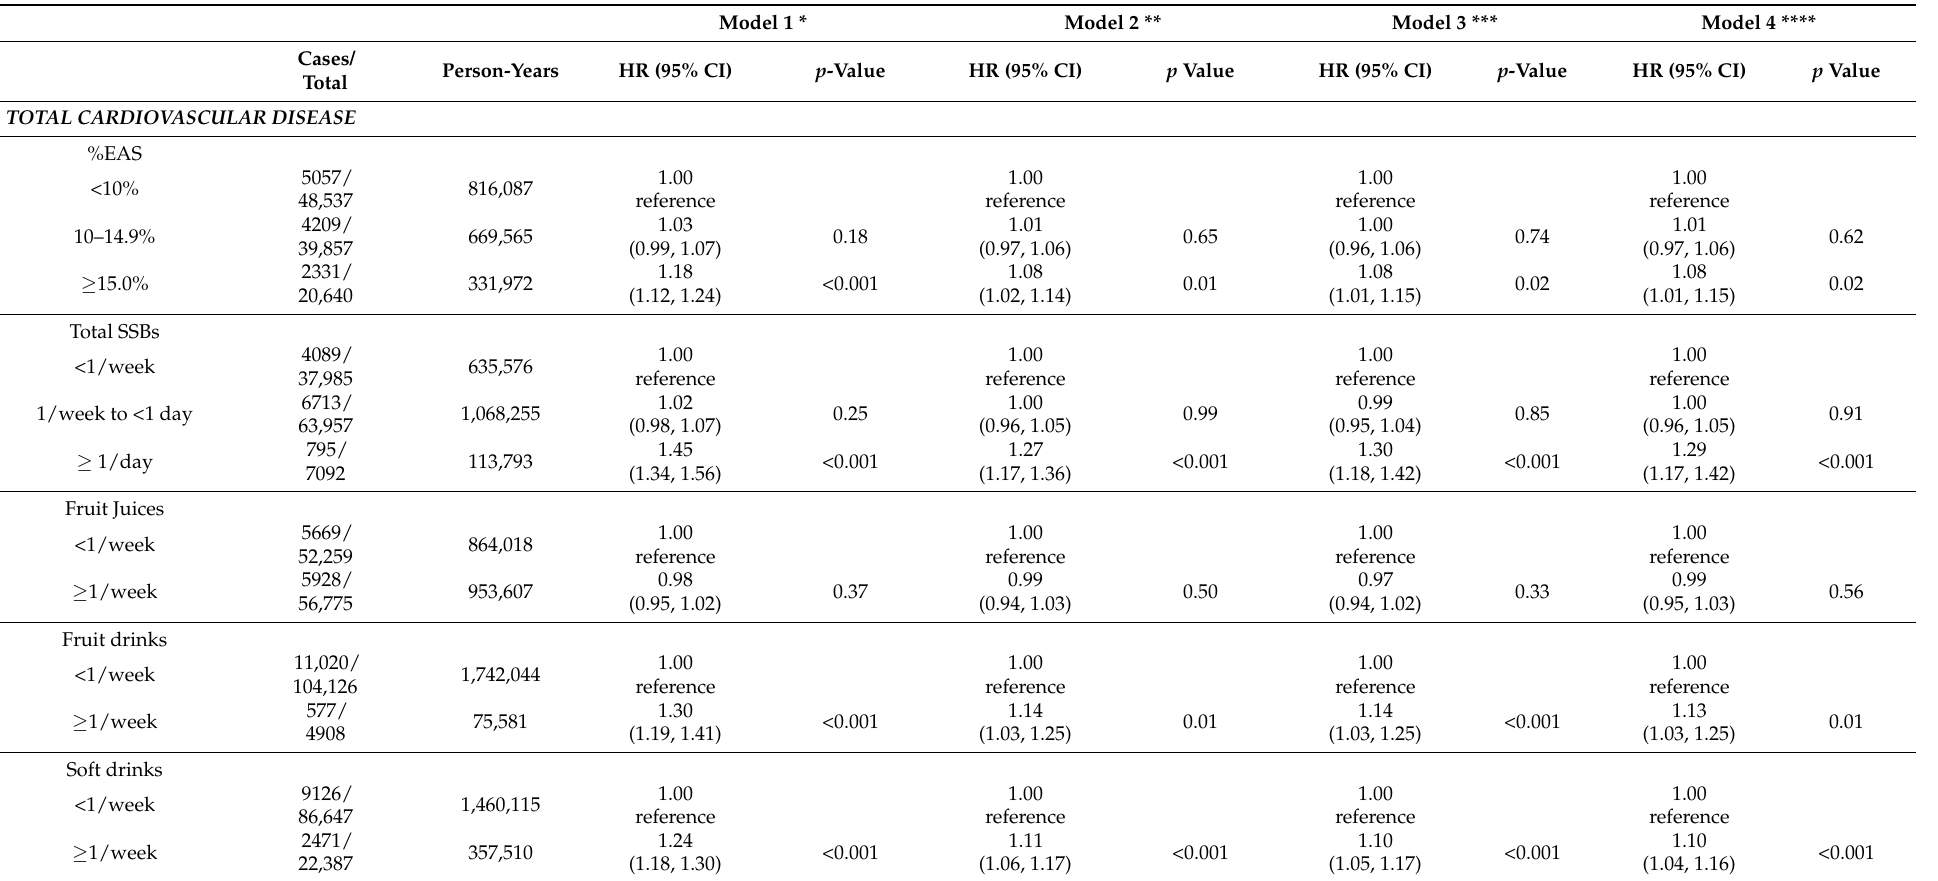
Table 2. Prospective association of added sugars and SSBs with total cardiovascular disease, coronary heart disease, and heart failure among 109,034 participants in the Women’s Health Initiative (CT + OS)